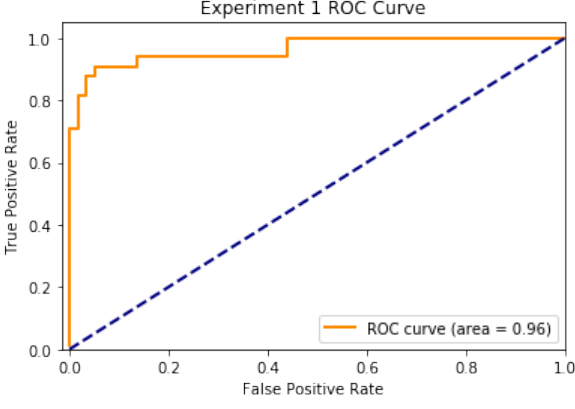
Figure 10. Experiment 1 ROC